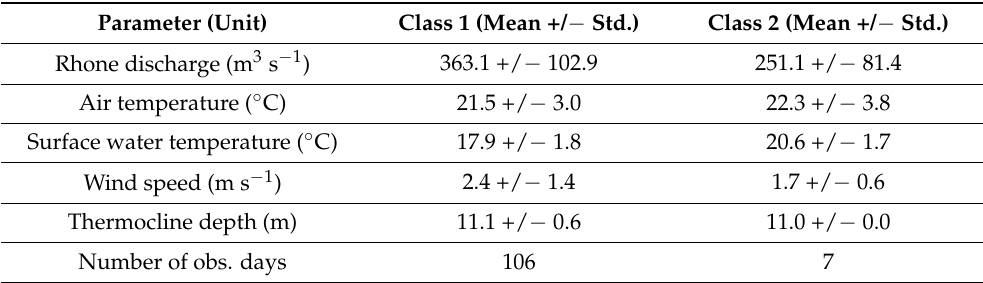
Table 2. Averaged environmental conditions during observed whiting days from 2013 to 2021 (>15 km 2 ) in Lake Geneva. The standard deviations for each condition are also specified. The number of whiting days for each class is